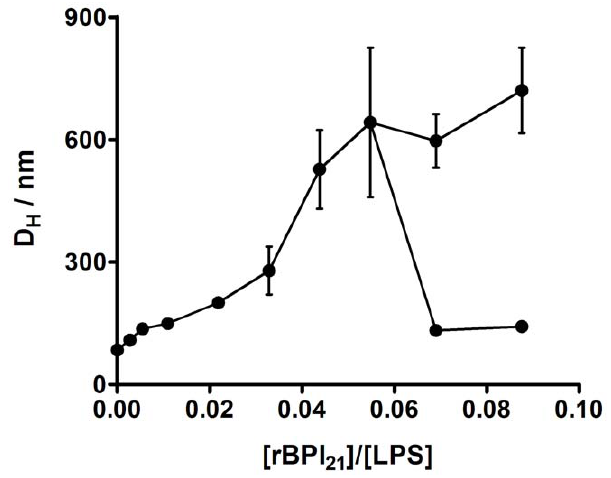
Figure 2. Aggregation of LPS promoted by rBPI 21 . Hydrody- namic diameter variation of LPS aggregates with increasing rBPI 21 concentration. Bars represent the size range from three independent